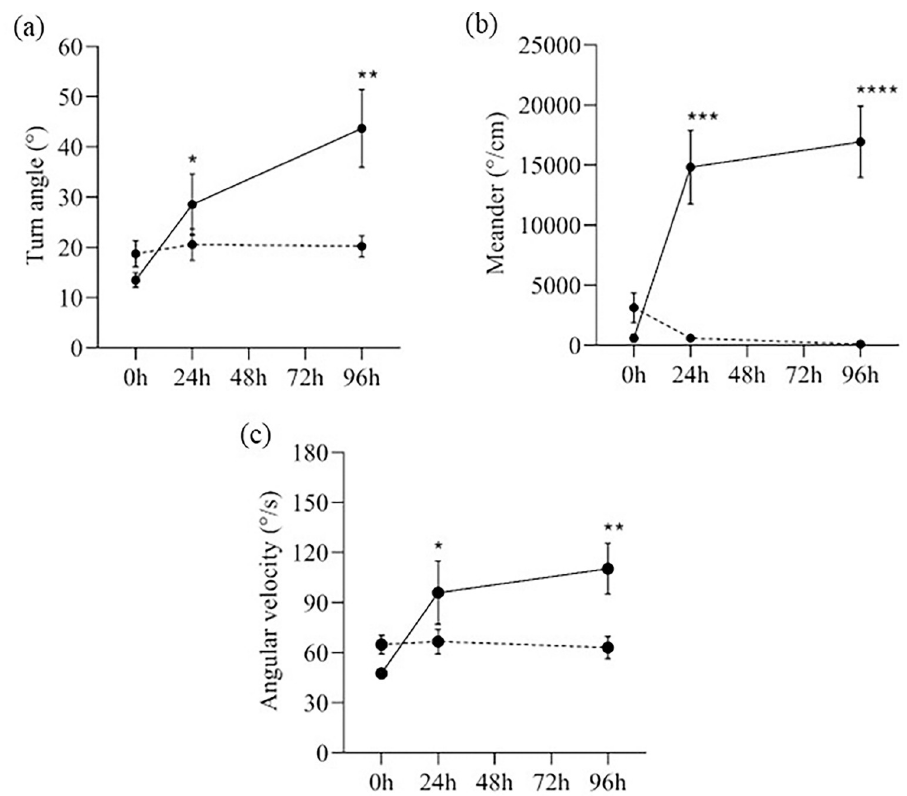
Fig 7. Turning rate of MPTP-injected (solid lines) and control (dashed lines) zebrafish. (a) Turn angle (in degree), (b) Meander (in degree/cm), and (c) Angular velocity (in degree/s) at different time-points after the injection. Two- way RM ANOVA revealed that there were statistically significant interactions between the effects of MPTP injection and time on meander (F (2,76) = 18.92, p < 0.0001), angular velocity (F (2,76) = 5.34, p = 0.007), and turn angle (F (2,76) = 6.40, p = 0.003). Post-hoc Tukey’s test found that the mean meander, angular velocity, and turn angle of MPTP-injected group were significantly different between 0h and 24h (turn angle: p = 0.045, 95% CI = [-29.87, -0.2828]; meander: p = 0.0005, 95% CI = [–22021, –6436]; angular velocity: p = 0.047, 95% CI = [-96.09, -0.5698]), and between 0h and 96h (turn angle: p = 0.002, 95% CI = [-48.96, -11.42]; meander: p < 0.0001, 95% CI = [–24002, –8704]; angular velocity: p = 0.001, 95% CI = [-99.85, -25.66]). All values are presented as mean and error bars represent the SEM. n = 20 per group. � p < 0.05, �� p < 0.01, ��� p < 0.001, ���� p < 0.0001.